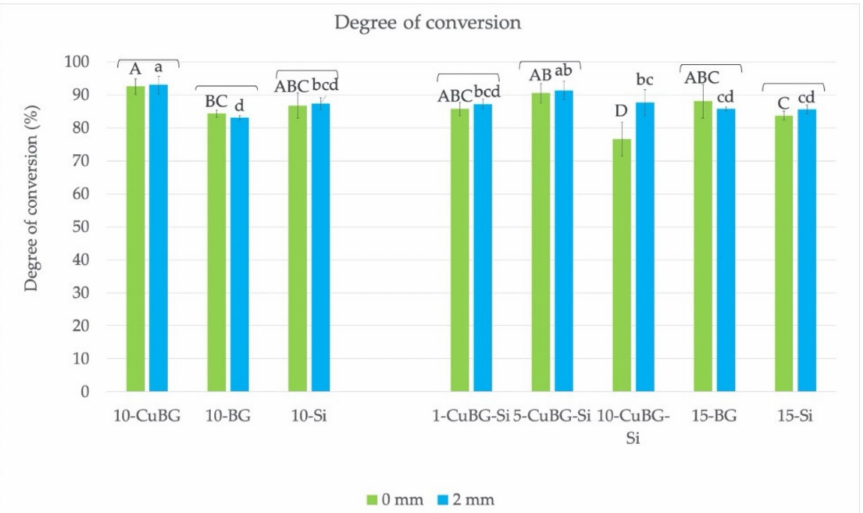
Figure 6. Degree of conversion of the tested materials 1 day after polymerization and exposure to saline solution. Upper case letters indicate no statistically significant differences between groups at the top (0 mm) surface. Lower case letters indicate no statistically significant differences between groups at the bottom (2 mm) surface. Brackets indicate no statistically significant difference within the same material between the top and bottom